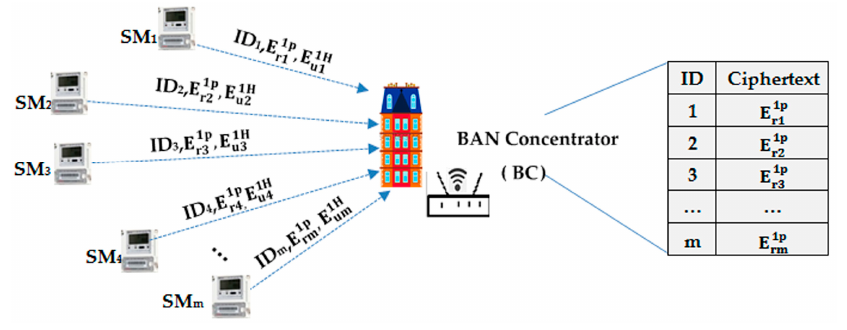
Figure 2. BC storage diagram.